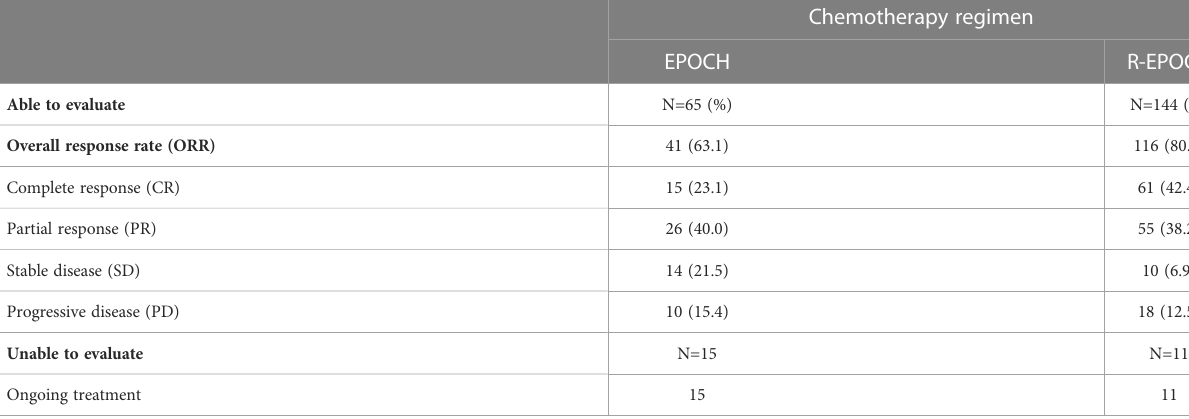
TABLE 2 Response evaluation following chemotherapy in